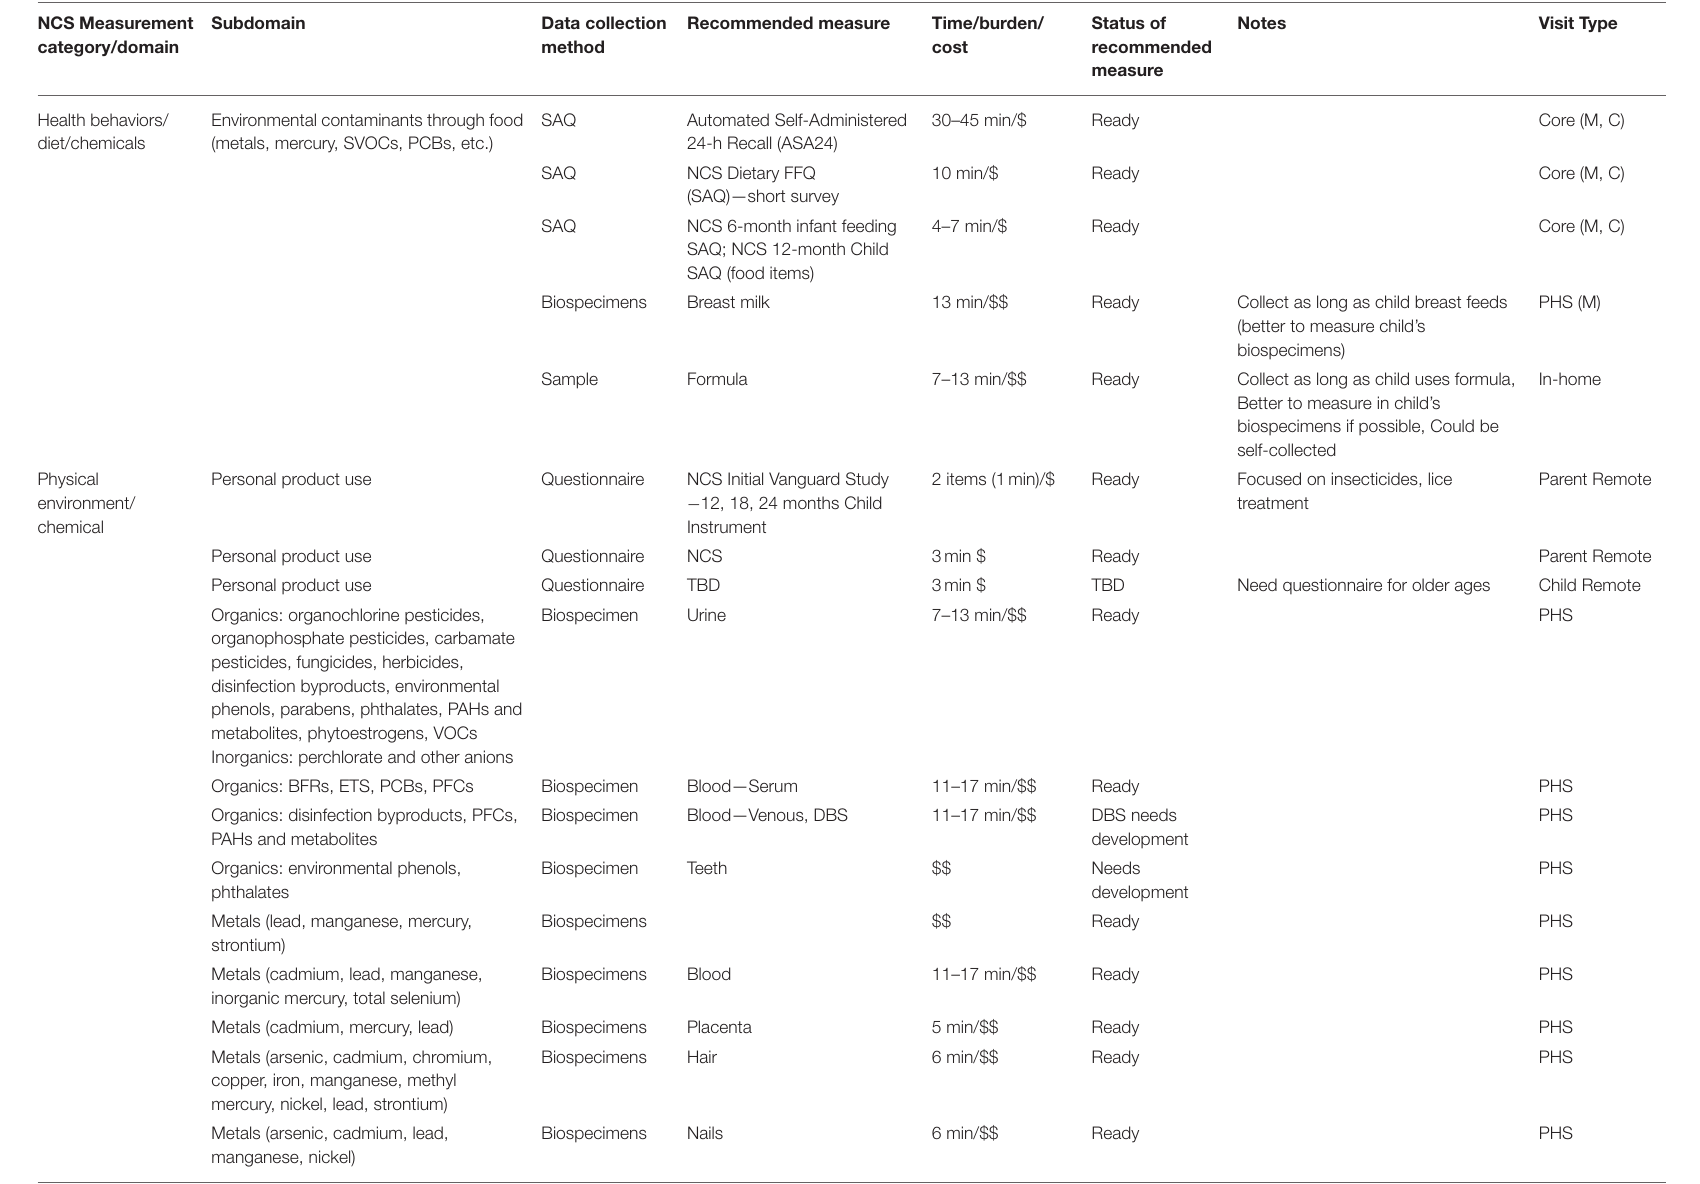
TABLE 1 | Domain: Chemical